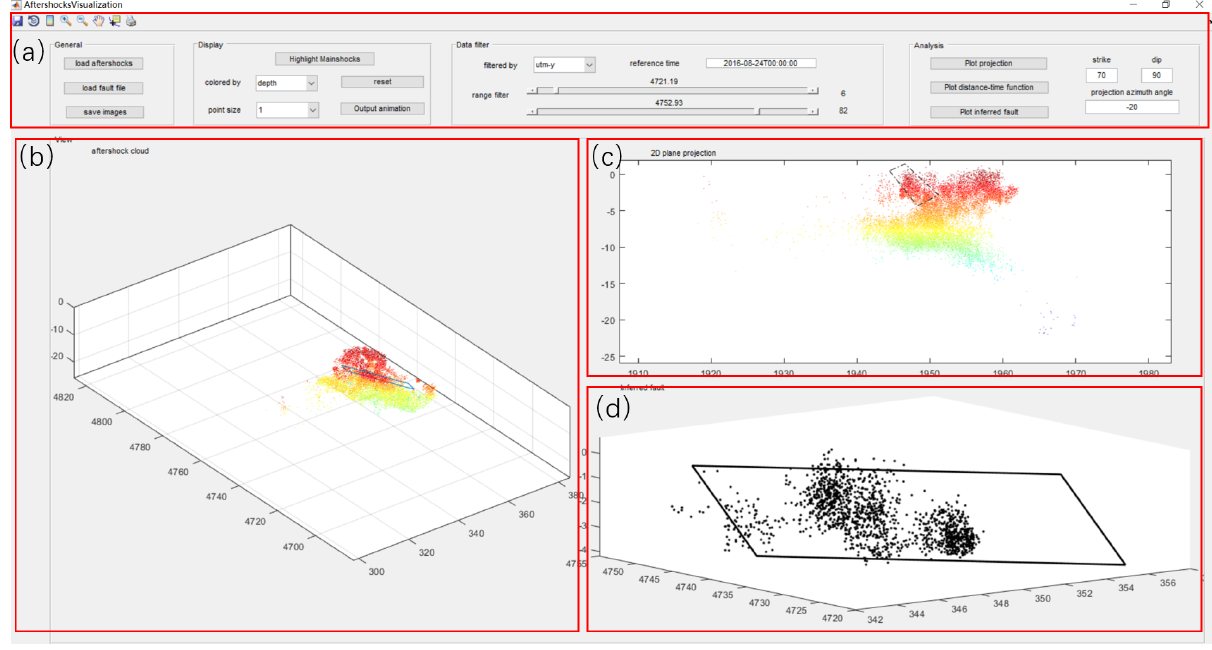
Figure 2. Visual interface of our approach consisting of four interrelated components: (a) operation tools, (b) a 3-D view, (c) a 2-D projection view, and (d) a temporal view for plotting a fitted fault plane or distance–time